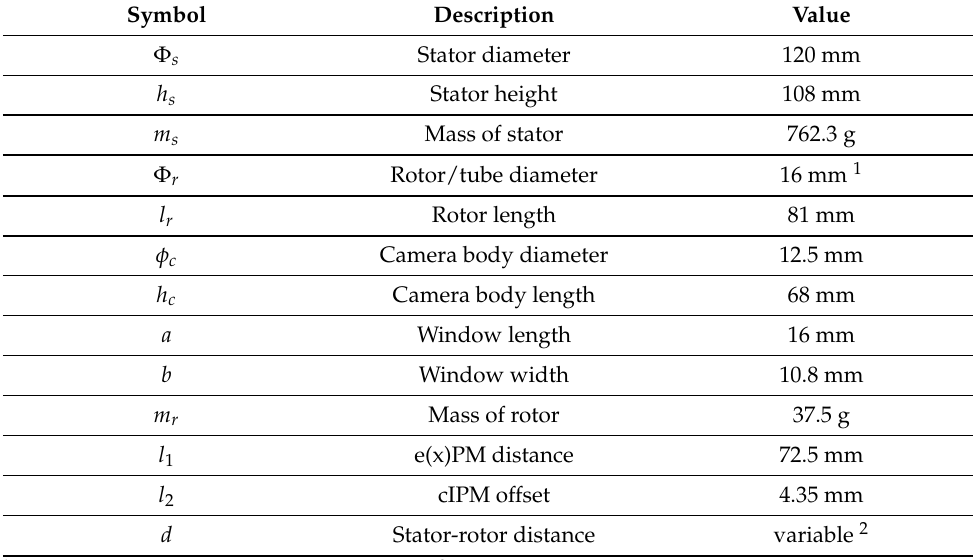
Figure 4. Mechanical design and fabrication of the rotor. Table 2. Physical attributes of the stator and the